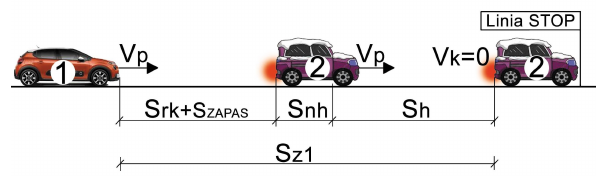
Figure 1: Keeping the distance behind the preceding vehicle braking rapidly